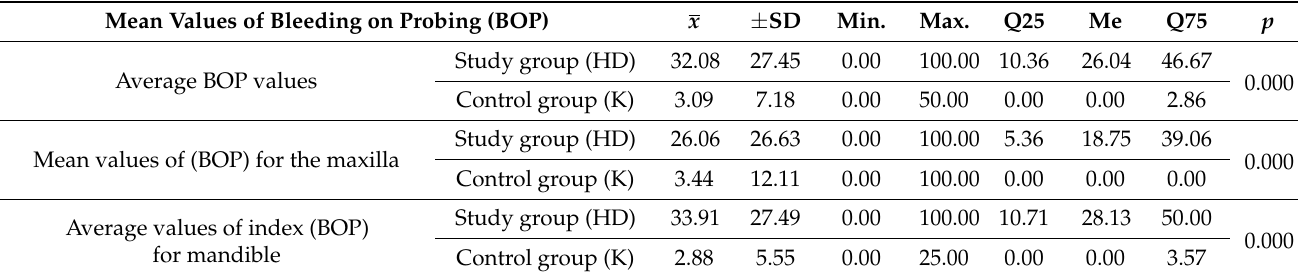
Table 9. Mean values of BOP index in the study